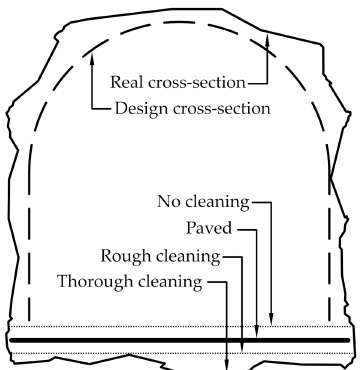
Figure 3. Different methods for tunnel invert cleaning (adapted with permission from from [26] (Copyright 1997 Pål-Egil